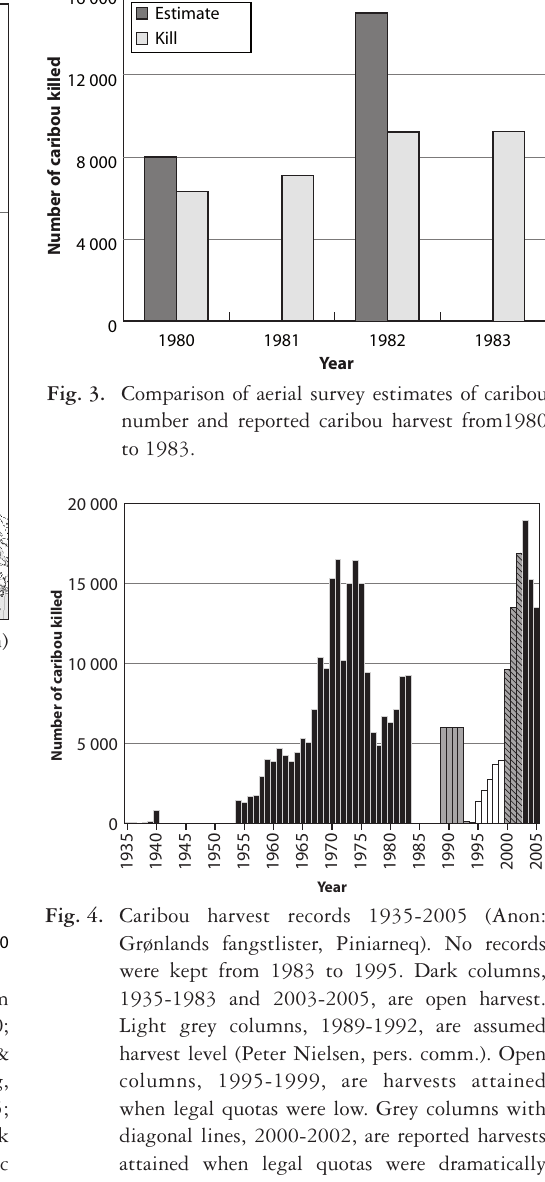
Fig. 4. Caribou harvest records 1935-2005 (Anon: Grønlands fangstlister, Piniarneq). No records were kept from 1983 to 1995. Dark columns, 1935-1983 and 2003-2005, are open harvest. Light grey columns, 1989-1992, are assumed harvest level (Peter Nielsen, pers. comm.). Open columns, 1995-1999, are harvests attained when legal quotas were low. Grey columns with diagonal lines, 2000-2002, are reported harvests attained when legal quotas were dramatically